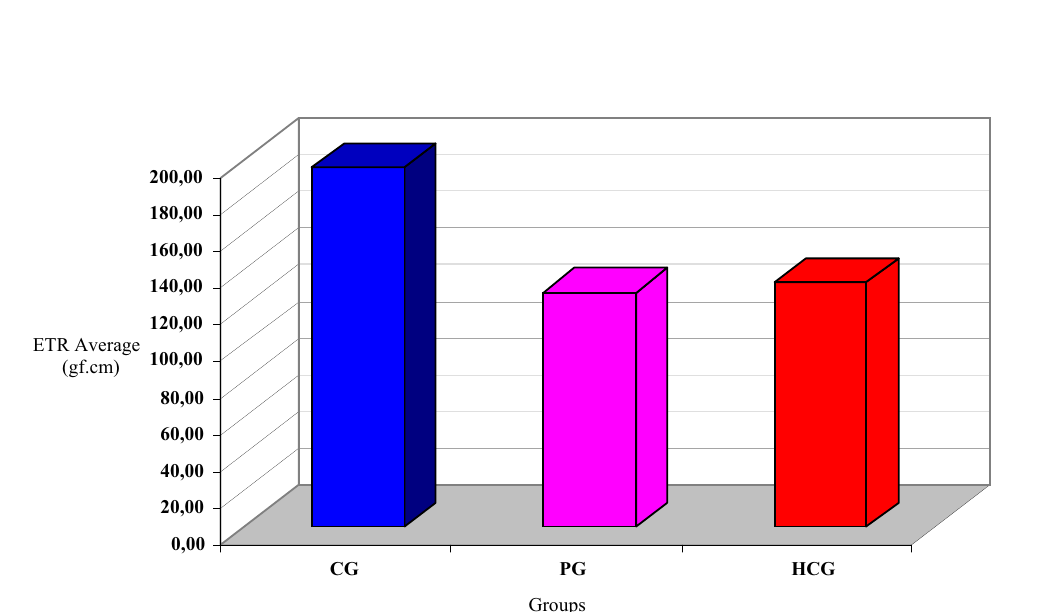
FIGURE 4 – Graphic distribution of total energy rupture values, in gf.cm, belonging to the CG, PG and HCG